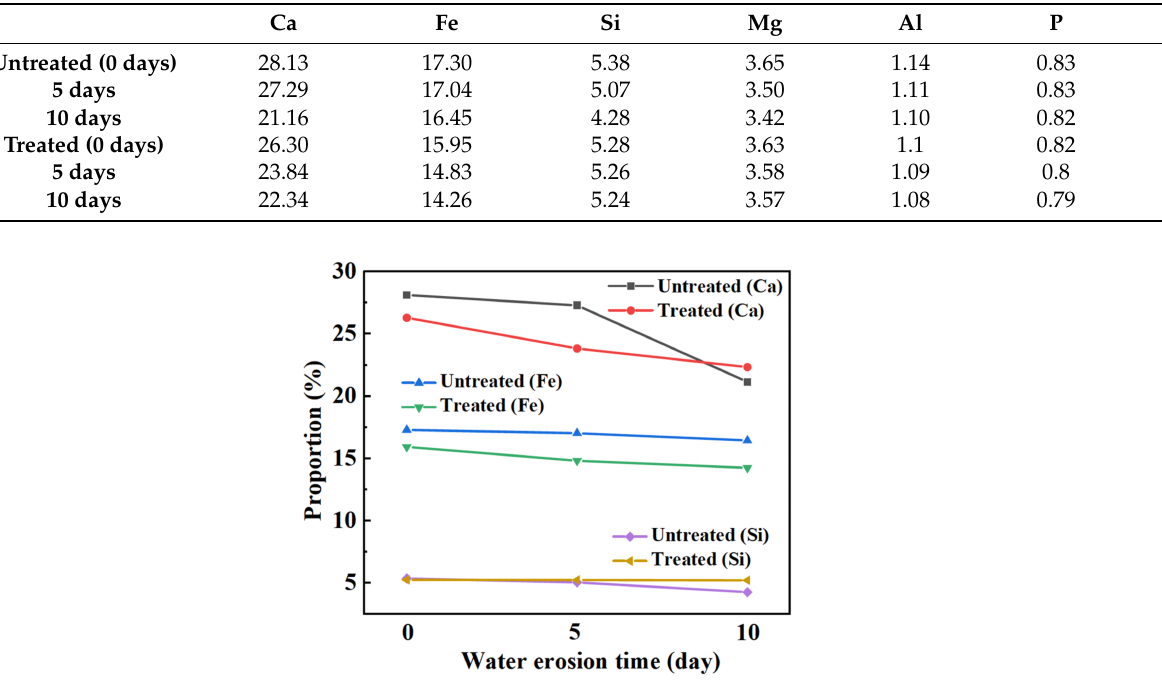
Table 11. Changes in chemical elements under different water erosion times (Wt.%).